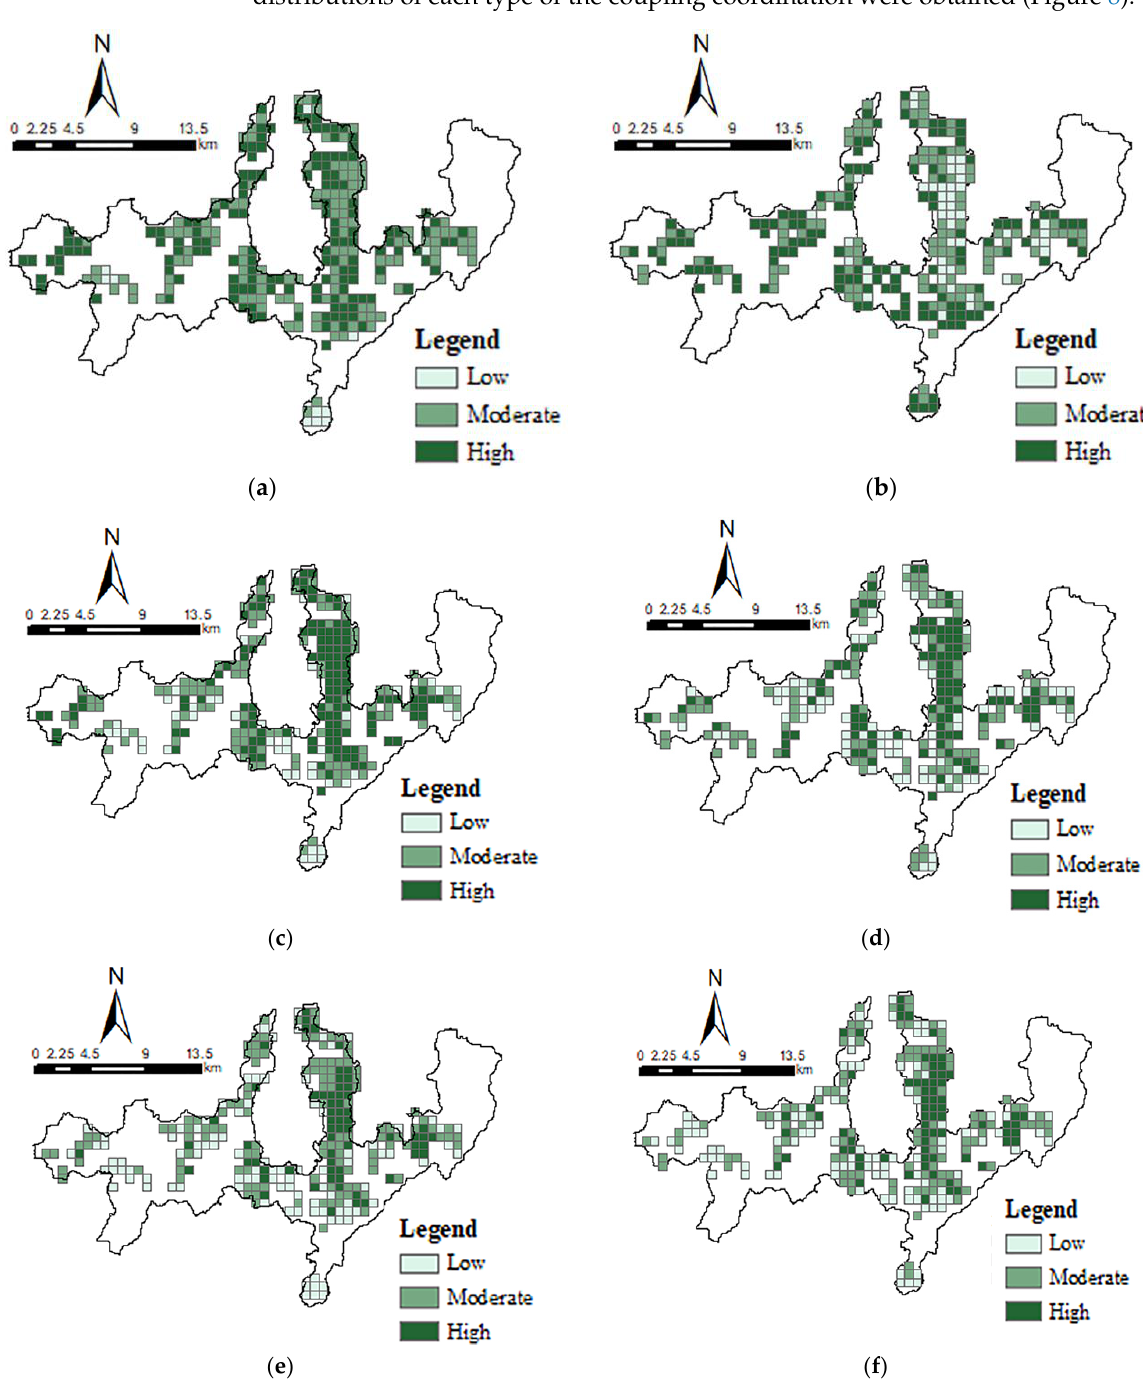
Figure 8. Spatial distribution of the coupling coordination between ( a ) woodland landscape- fragmentation index and AREA_MN, ( b ) biological reserve landscape-fragmentation index and AREA_MN, ( c ) woodland landscape-fragmentation index and CONTAG, ( d ) biological reserve landscape-fragmentation index and CONTAG, ( e ) woodland landscape-fragmentation index and